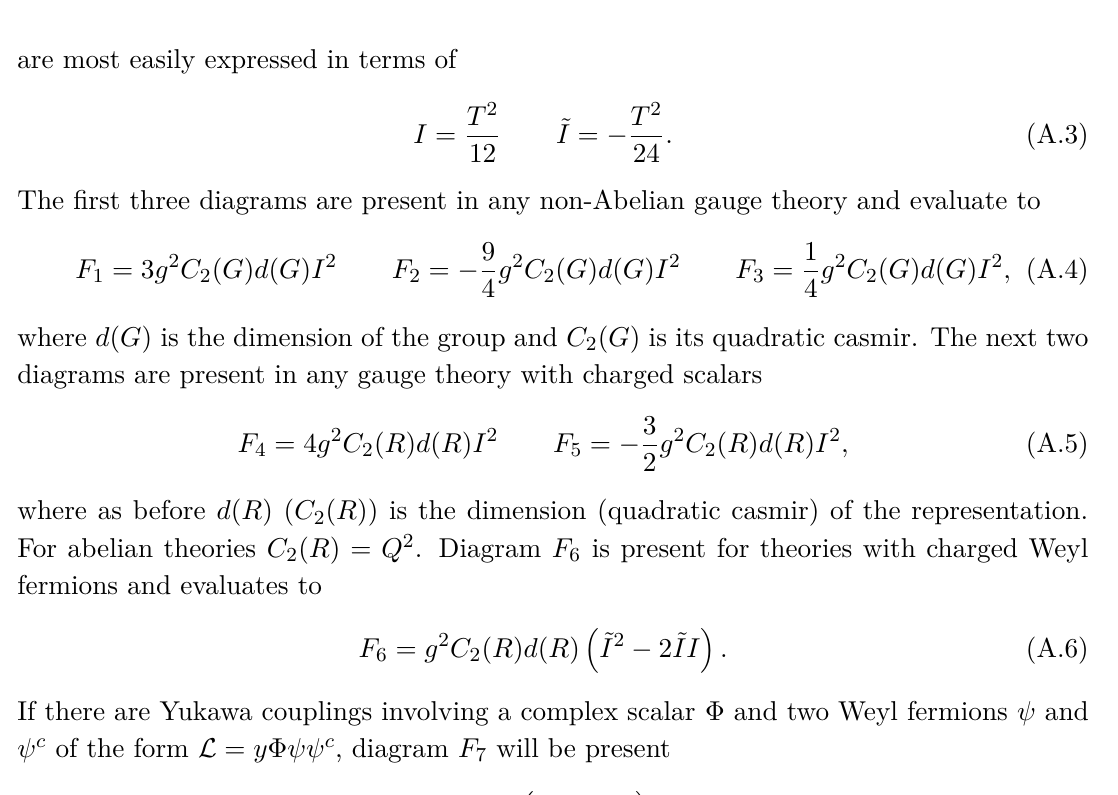
Figure 9 . The eight leading order diagrams contributing to the free energy that lead to w ( T ) 6 = 1 / 3 . F 1 , 2 , 3 involve gauge bosons and/or ghosts and are present for any non-abelian gauge theory. F 4 , 5 ( F 6 ) are present whenever there is a scalar (fermion) charged under a gauge group. F 7 is the leading diagram for Yukawa couplings while F 8 is the leading diagram for quartic